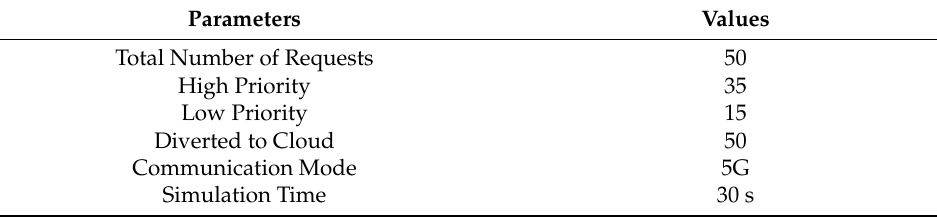
Table 5. Cloud scenario 2.